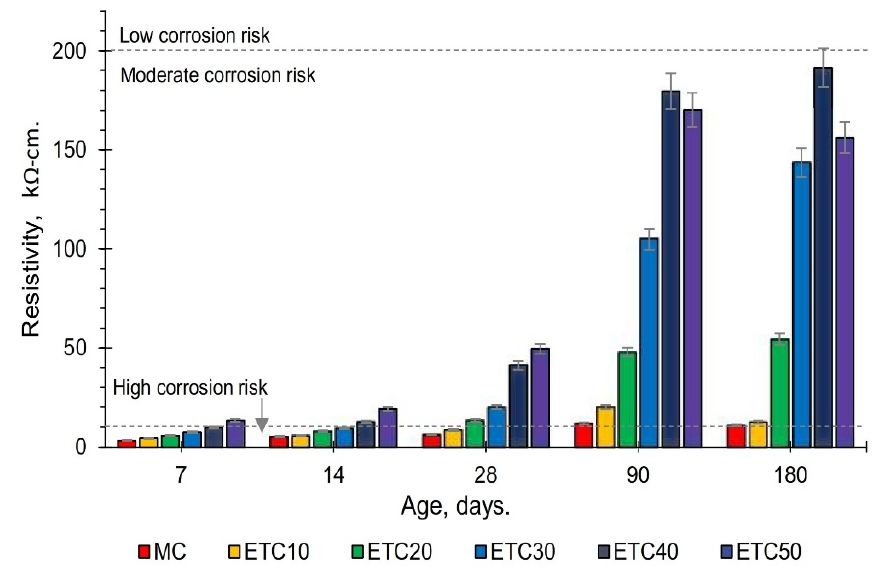
Figure 10. Electrical resistivity of the study concretes.